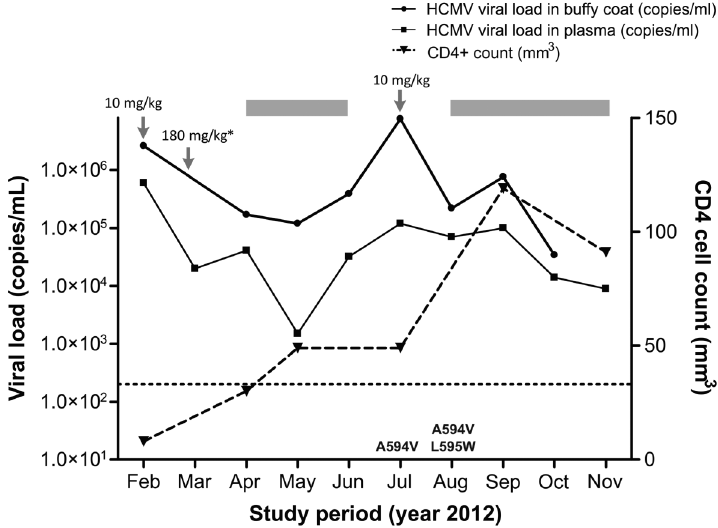
Figure 2. Changes in the human cytomegalovirus load (HCMV) (plasma and buffy coat) and the CD4 + Tcell count over the study period. Gray bars: continuous treatment with 5 mg/kg daily ganciclovir iv . Changes in the applied dose of ganciclovir are indicated at February and July. The ganciclovir resistance mutations are indicated at the bottom of the graph. * iv